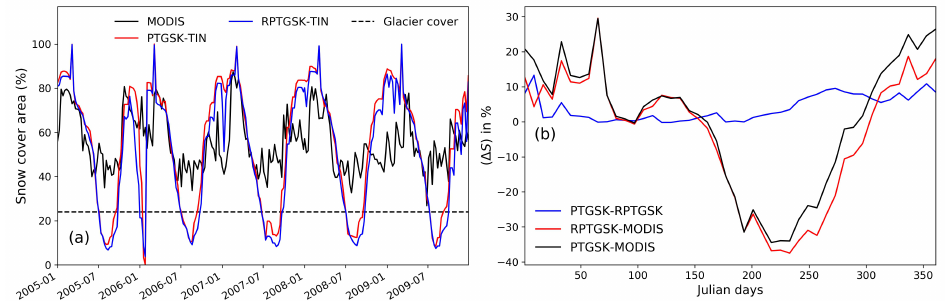
Figure 8. ( a ) Catchment scale 8-day maximum snow cover area (%) from MODIS, PTGSK-TIN, and RPTGSK-TIN. ( b ) Snow cover area percentage differences between PTGSK-TIN and RPTGSK-TIN (blue), RPTGSK-TIN and MODIS (red), and PTGSK-TIN and MODIS